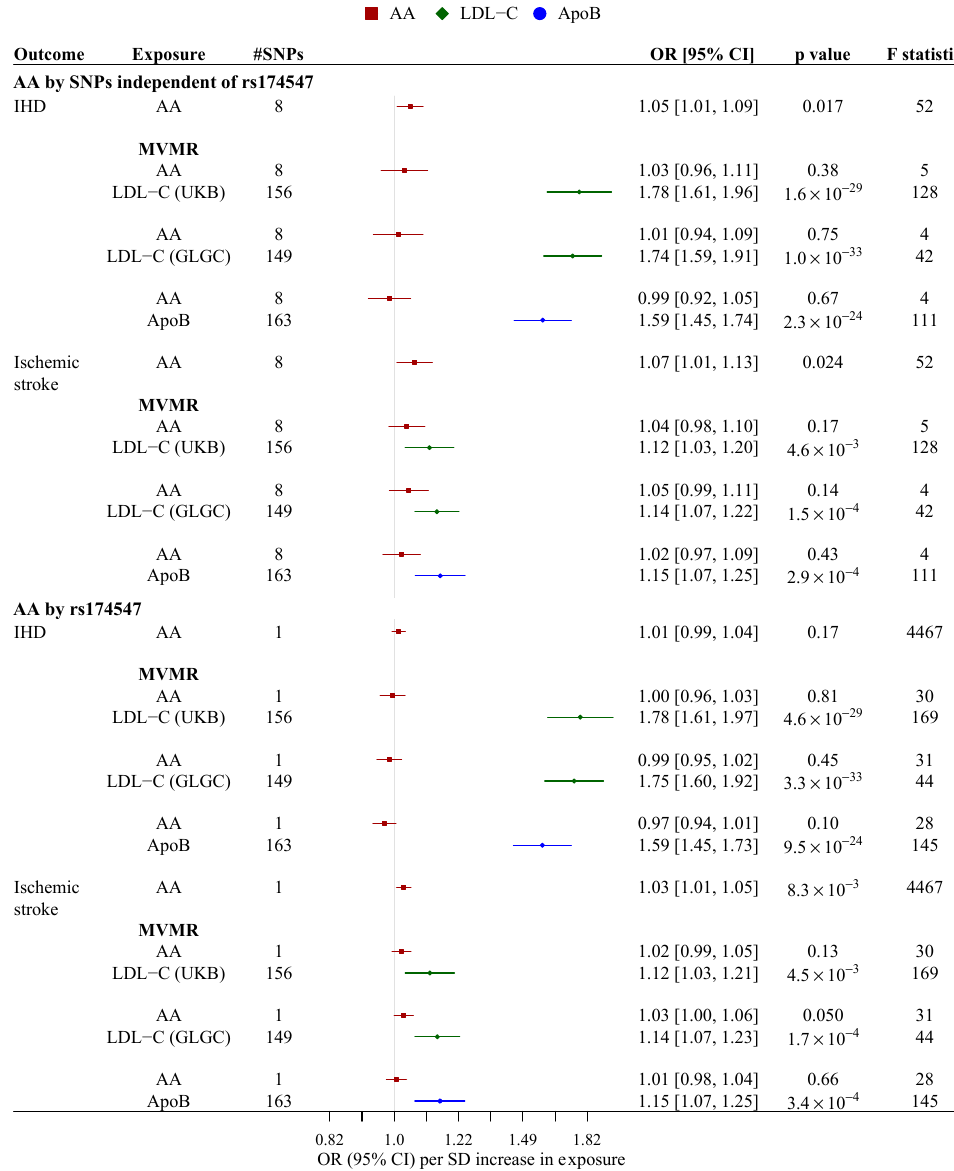
Figure 3. Multivariable Mendelian randomization estimates for associations of genetically predicted arachidonic acid synthesis with ischemic heart disease and ischemic stroke after adjustment for LDL-C or ApoB. F statistic indicated mean F-statistic in the univariable models and conditional F-statistic in the multivariable models. For IHD, the estimates were derived from meta-analyses of random-effect multivariable inverse variance weighting estimates from CARDIoGRAM- plusC4D 1000 Genomes ( n case = 60,801, n control = 123,504) and UK Biobank ( n case = 37,672, n control = 382,052); for ischemic stroke, the estimates were derived from meta-analyses of random-effect multivariable inverse variance weighting estimates from MEGASTROKE ( n case = 34,217, n control = 406,111) and UK Biobank ( n case = 4275, n control = 416,256). For all meta-analyzed esti- mates, p for heterogeneity >0.05. AA, arachidonic acid; ApoB, apolipoprotein B; CI, confidence interval; GLGC, the Global